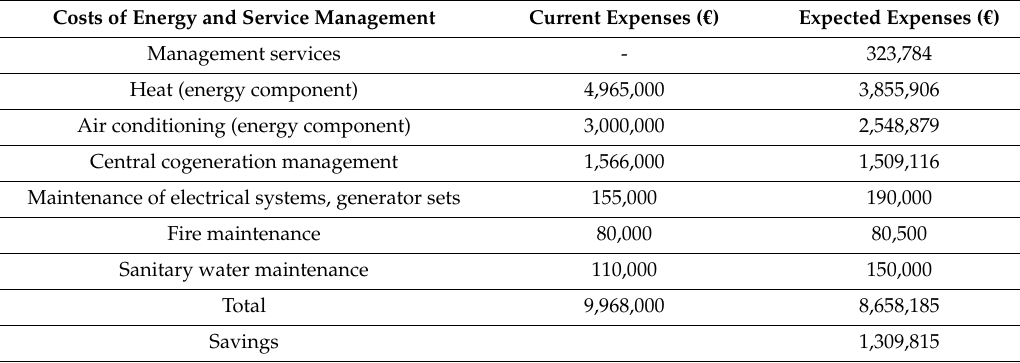
Table 2. Current and expected expenses for energy services in AL